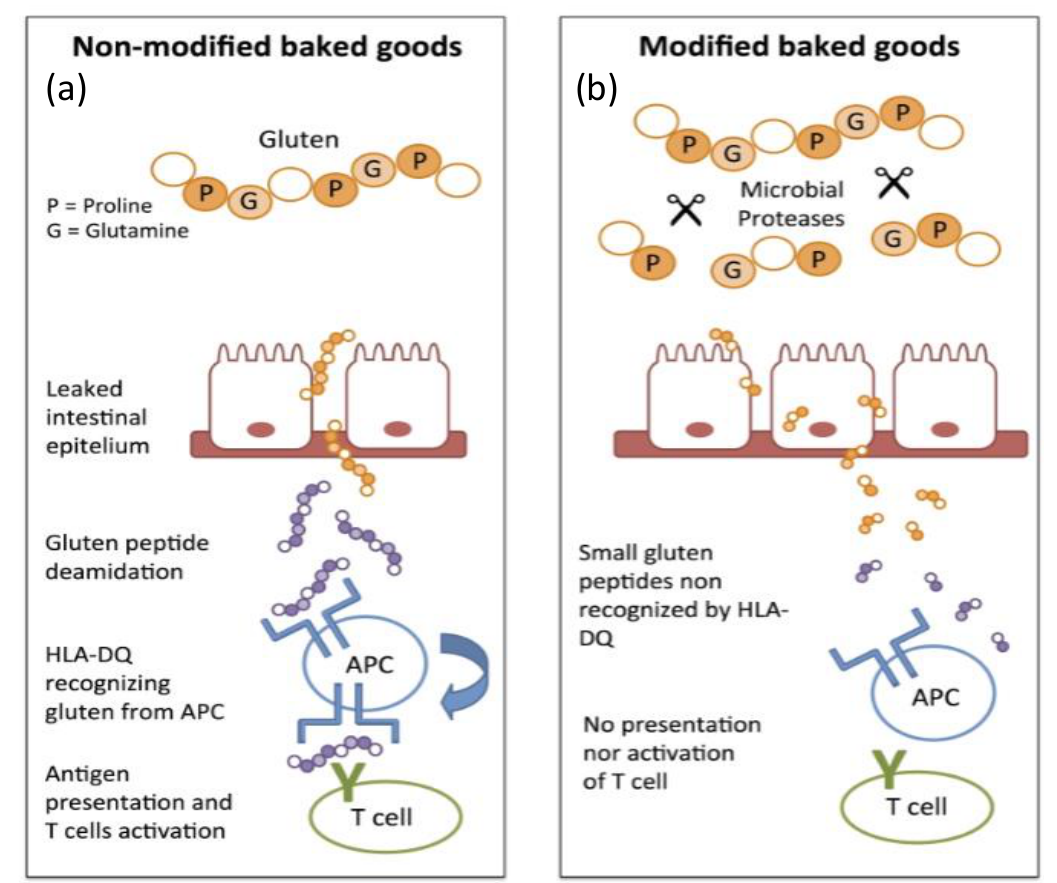
Figure 1. Adaptive immune response to: ( a ) non-modified baked goods; ( b ) and non-activation of T cells to modified baked goods by microbial proteases. Abbreviation: APC: antigen-presenting cell.